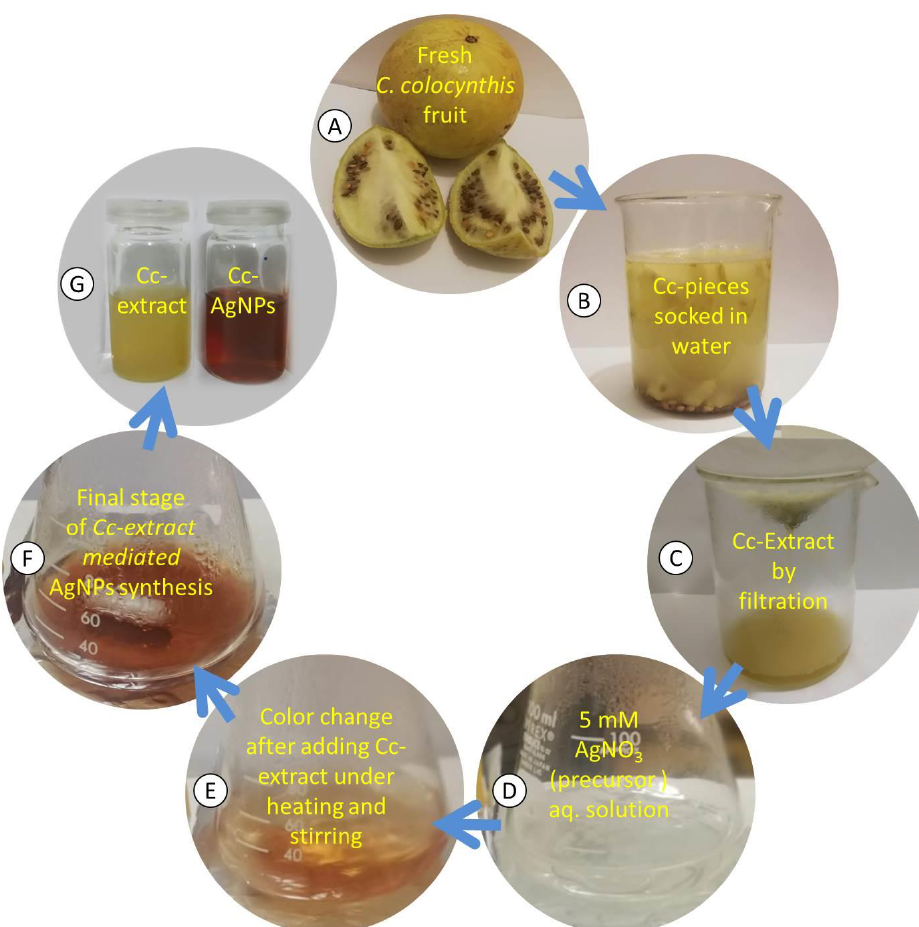
Figure 1. ( A – C ) Schematics of different stages during the preparation of C. colocynthis extract (Cc extract). ( D – F ) Synthesis of C. colocynthis silver nanoparticles (Cc-AgNPs) using Cc extract. ( G ) Colloidal samples of Cc extract and Cc-AgNPs.